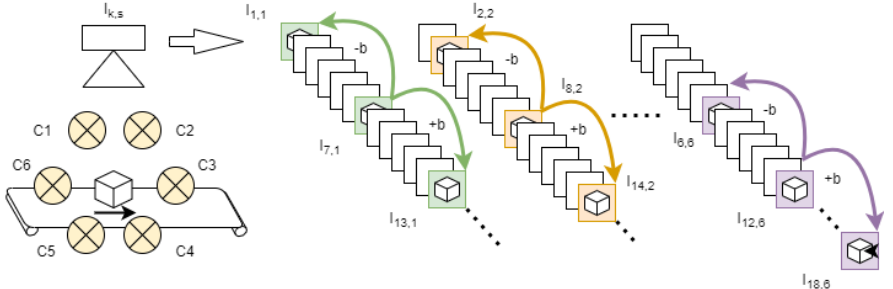
Figure 5. A schematic of the Algorithm, showing the individual images I [ k , s ] acquired with the system and the corresponding matching images I [ k − b , s ] , I [ k + b , s ] , which are further used to calculate the individual disparity maps, further used for our